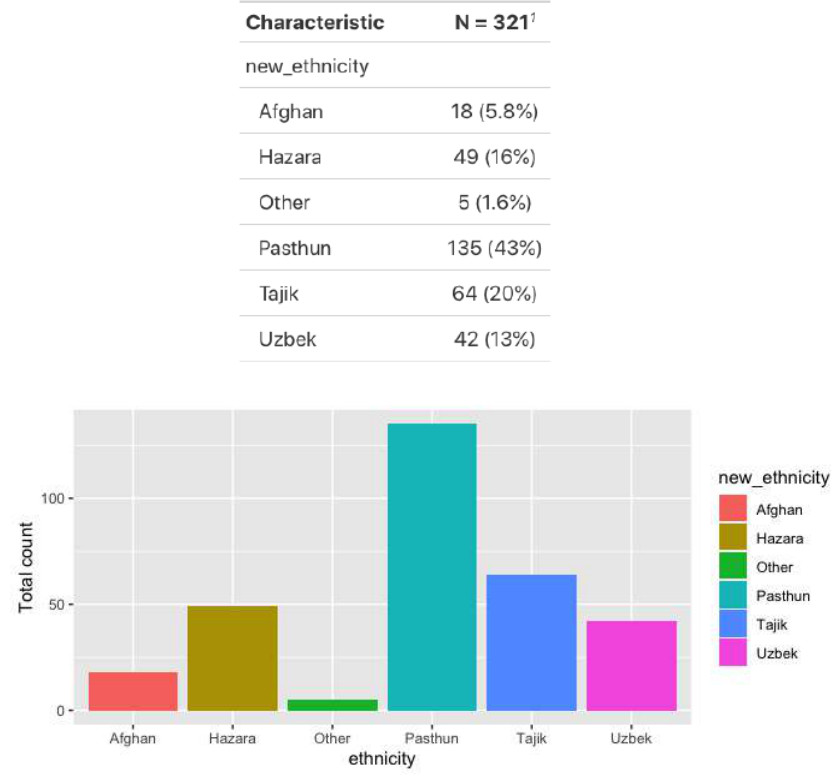
Figure 2: Ethnic Distribution of Respondents (Source: Authors‟ depiction )